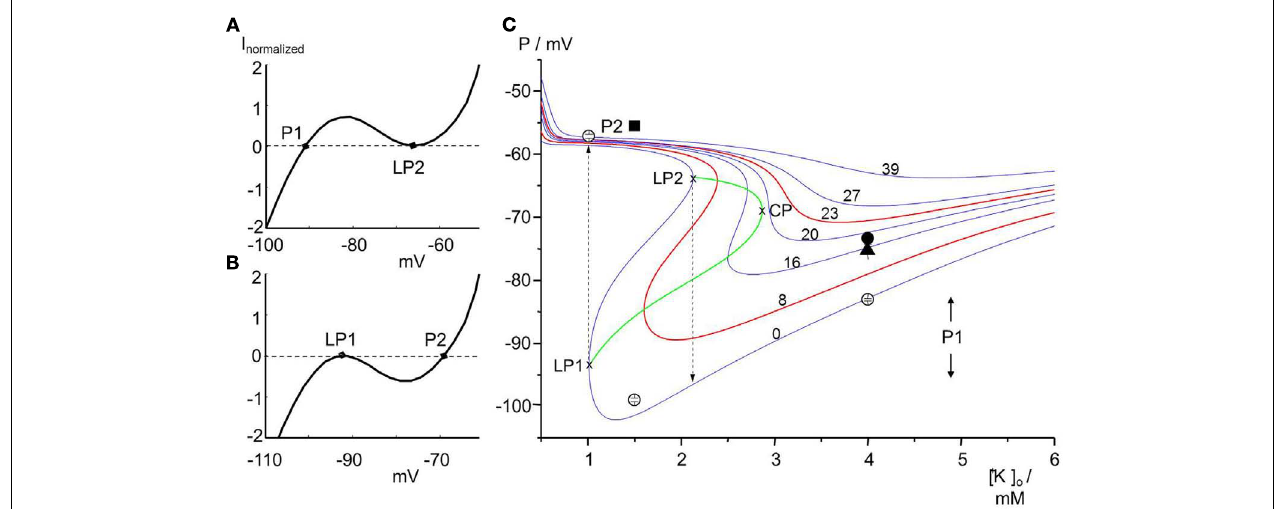
FIGURE 4 | Effects of omega currents schematically (A) and in a computer simulation (B). (A) The current-voltage relationship of K ir potassium channels shows a voltage range characterized by a “negative” resistance.This negativity leads to membrane bi-stability.Whereas small instantaneous changes of P1 will be compensated for (P1 is therefore a stable membrane potential), larger depolarizing artifacts will cause a jump of P1 to the limit point LP2. P1 can be regained by substantial repolarizing influences like the Na/K pump. (B) The curve is downwardly shifted by an omega Na + current. Limit point LP1 is a very instable membrane potential that will be shifted to P2 by even smallest instantaneous changes. In the P2-state the cell membrane will be electrically stable. (C) Membrane potentials P for various [K + ] o values and for various omega pore conductances (in μ S/cm 2 ). Reducing [K + ] o first leads to hyperpolarization until the limit point (LP1) is reached at which the membrane potential becomes instable and jumps to the depolarized state of about − 58mV. From there,